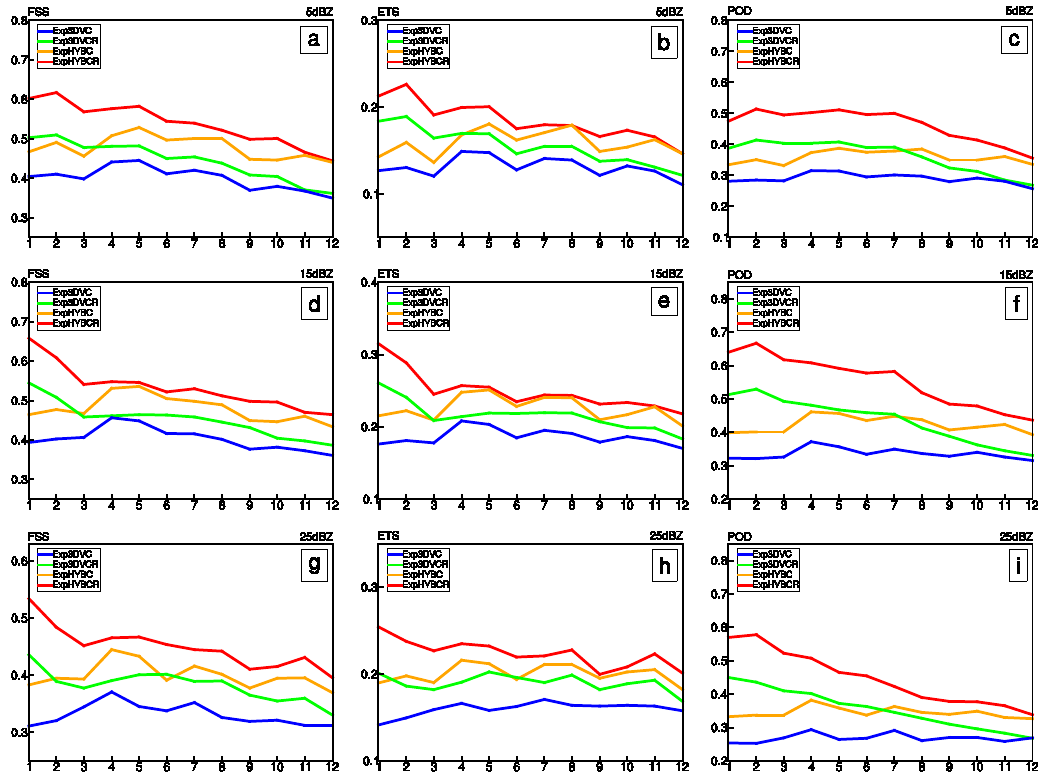
Figure 11. FSS ( a , d , g ), ETS ( b , e , h ) and POD ( c , f , i ) of Exp3DVC (blue curve), ExpHYBC (orange curve), Exp3DVCR (green curve) and ExpHYBCR (red curve) averaged over seven 0–12 h forecasts (initialized at 15:00, 18:00, 21:00, 00:00, 03:00, 06:00 and 09:00 UTC on 7 August, 2016), for reflectivity thresholds of 5, 15 and 25 dB Z .